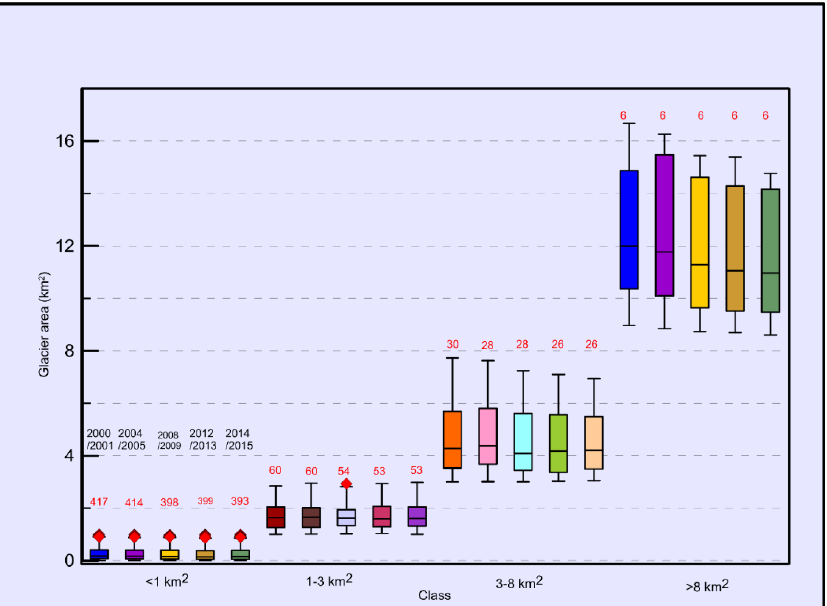
Figure 5. Box-whisker plot of different glacier area classes in Upper Reach of Shule River Basin; the red total is the number of glaciers in this class; the periods in the columns from left to right are 2000/2001, 2004/2005, 2008/2009, 2012/2013, and 2014/2015, respectively. The top and bottom of the whisker represent the maximum and minimum glacier area in each class, respectively; the top, median, and bottom of the box represent the 75%, 50%, and 25% quantiles of the glacier area in the class, respectively.